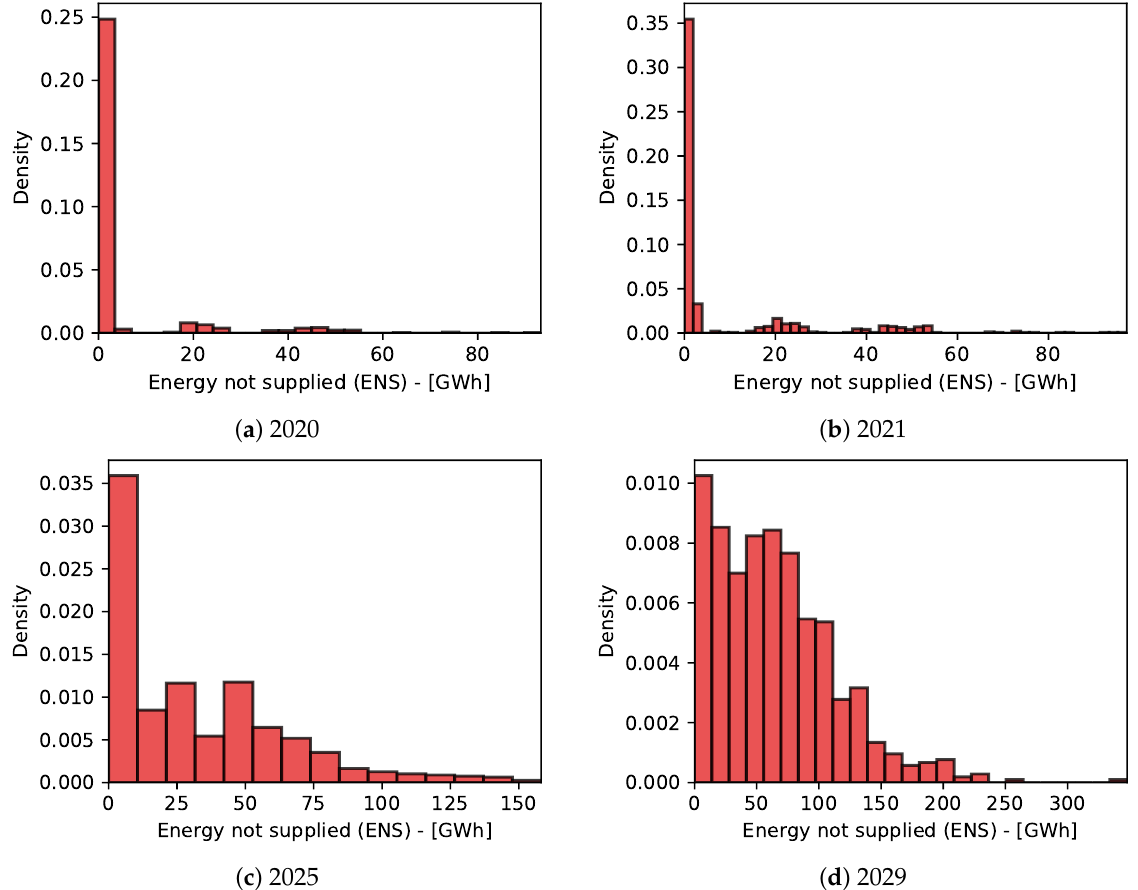
Figure 8. Histogram of the expected accumulated energy not supplied for each period of